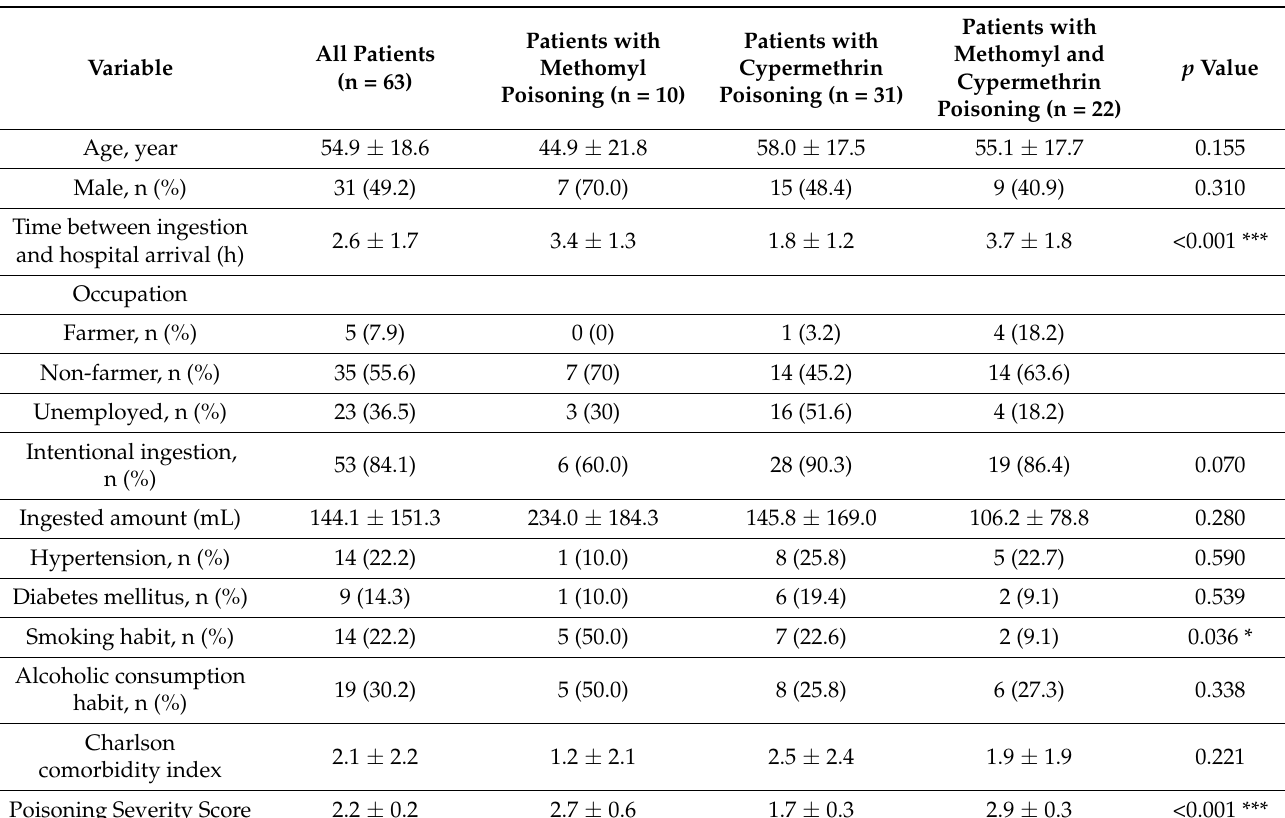
Table 1. Baseline characteristics of patients with pesticide poisoning, stratified by type of pesticide (n = 63).